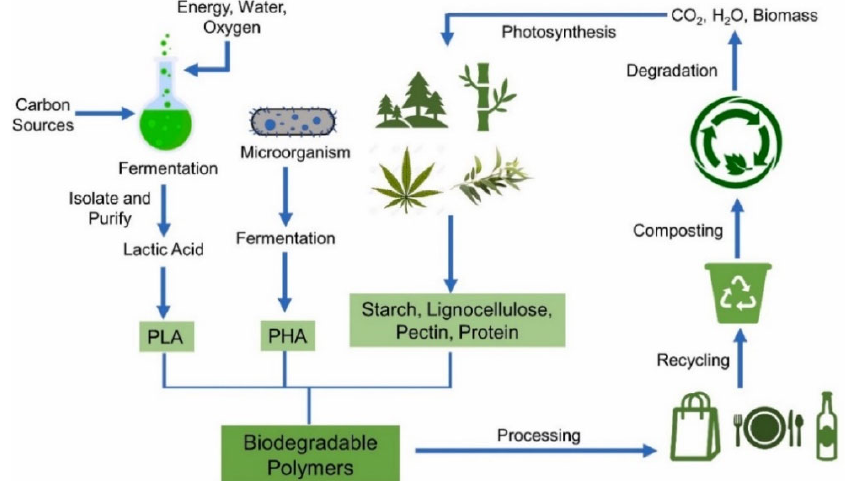
Figure 11. Flow chart for the recycling of polymers in the circular economy (reproduced with copyright permission from Tyagi et al. [57]).